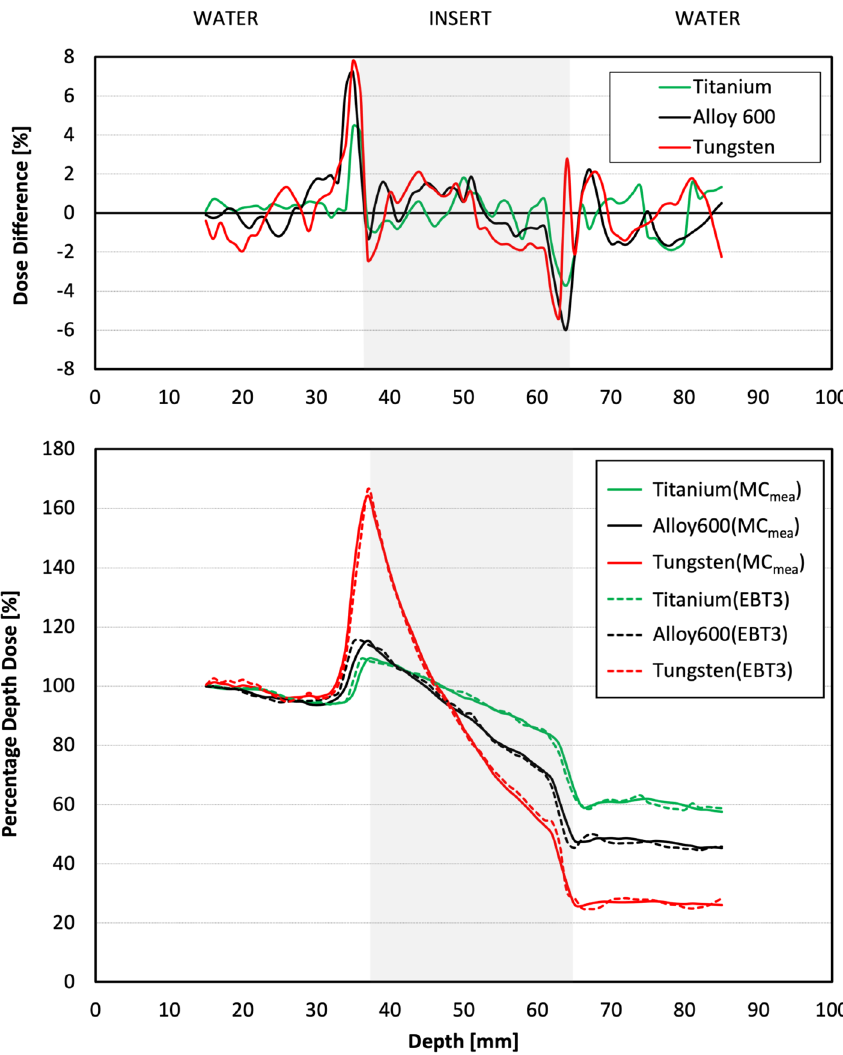
Figure 3. The comparison of dose differences and PDDs for measured (EBT3) and simulated (MC mea ) PDDs for titanium, alloy 600, and tungsten inserts.